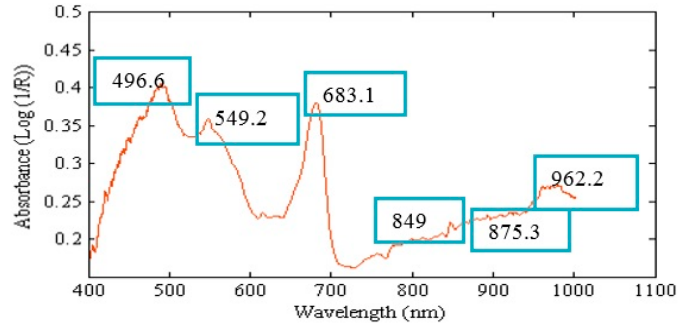
Figure 3. Mean absorption spectrum of VIS–NIR for the obtained apple samples.